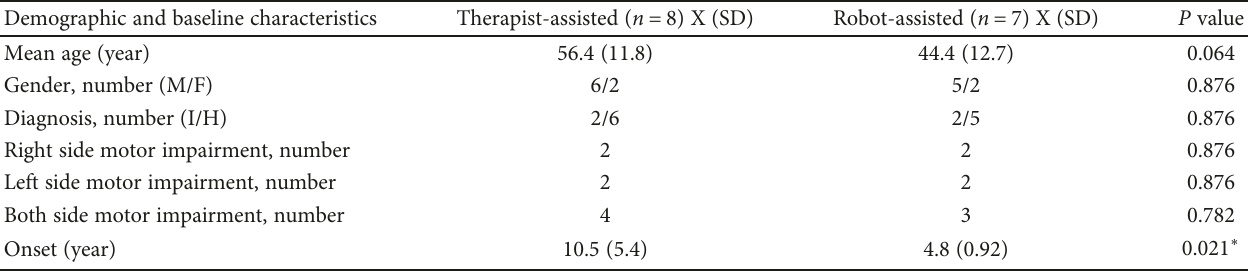
Table 1: Summary of demographic and baseline characteristics by intervention